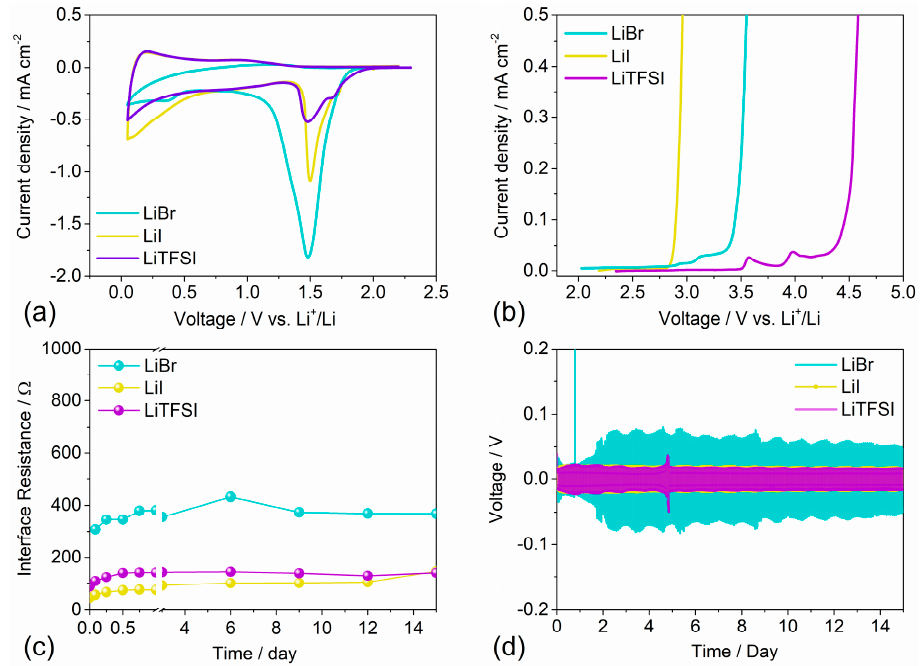
Figure 4. ( a ) Cyclic voltammetry tests—first cycle—for LiBr, LiI, and LiTFSI electrolytes performed in lithium − metal half − cells (2032 coin cells) using a copper foil coated with carbon (by employing Super P as active material) as the working electrode, recorded at a scan rate of 0.1 mV s − 1 in the 0.01 V − 2.2 V voltage range. ( b ) Linear sweep voltammetry of LiBr, LiI, and LiTFSI electrolytes performed in lithium-metal half-cells (2032 coin cells) using Super P on aluminum as the working electrode, recorded at a scan rate of 0.1 mV s − 1 in the OCV-5 V voltage range. ( c ) Li–electrolyte interface resistance evolution in time performed in symmetrical Li/Li cells obtained through electrochemical impedance spectroscopy applying a signal amplitude of 10 mV within 1 MHz-100 mHz frequency range at room temperature. ( d ) Voltage vs. time profiles of lithium stripping/deposition galvanostatic analysis of LiBr, LiI, and LiTFSI electrolytes, obtained by applying 0.1 mA cm − 2 current density in a symmetrical Li/Li cell at room temperature.